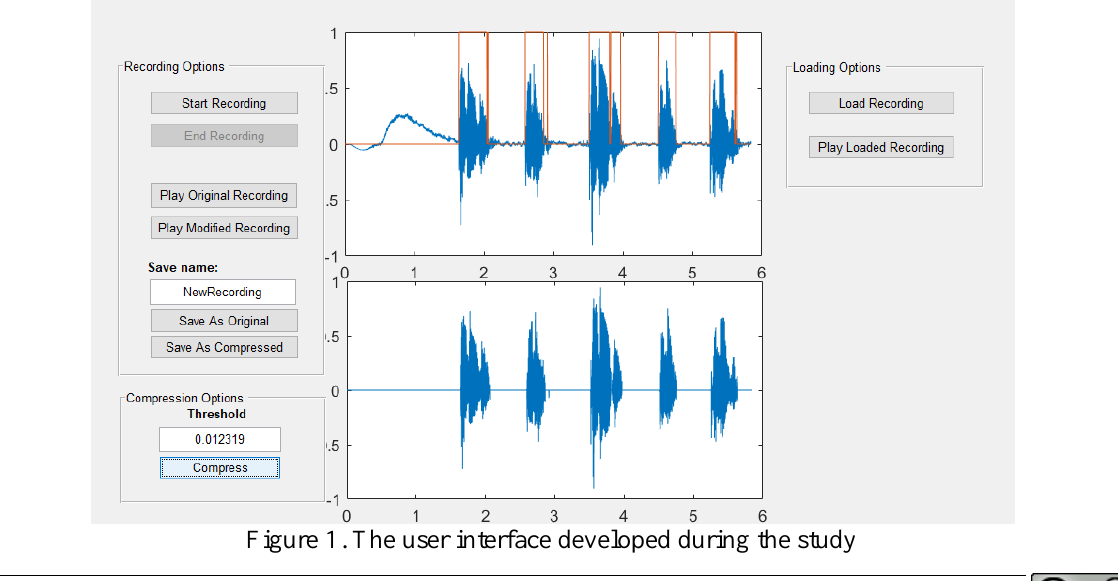
Figure 1. The user interface developed during the